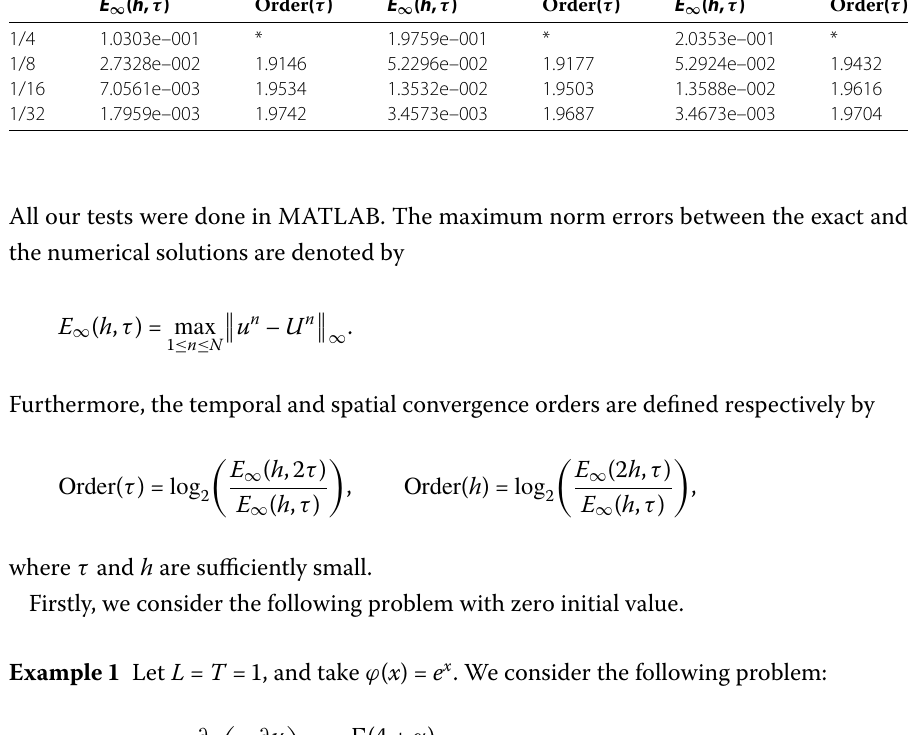
Table 1 The numerical convergence orders in temporal direction with h = 1 τ α =